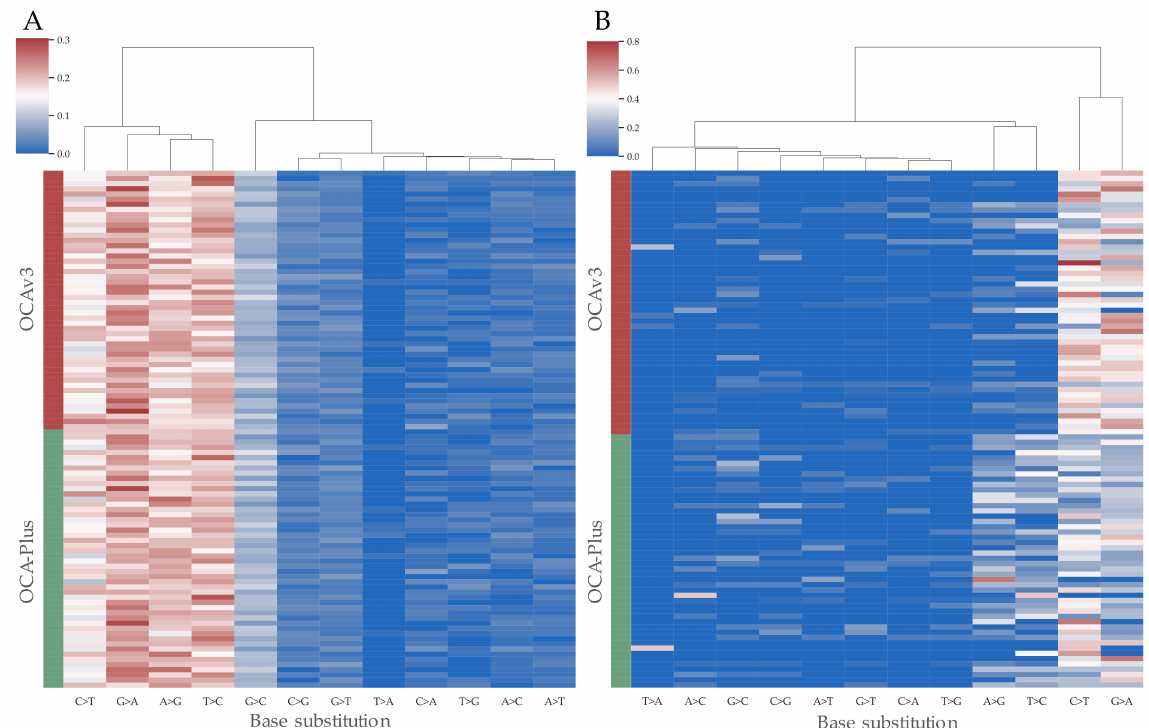
Figure 2. Potential sequence artifactual mutations are harbored in variants below the first quartile of mean sample allele ratios. ( A ) Cluster map of proportional base substitutions in variants above the first quartile. ( B ) Cluster map of proportional base substitutions in variants below first quartile of allele ratio. OCA-Plus harbored statistical lower levels of C > T and G > A but also significantly higher levels of A > G and T > C